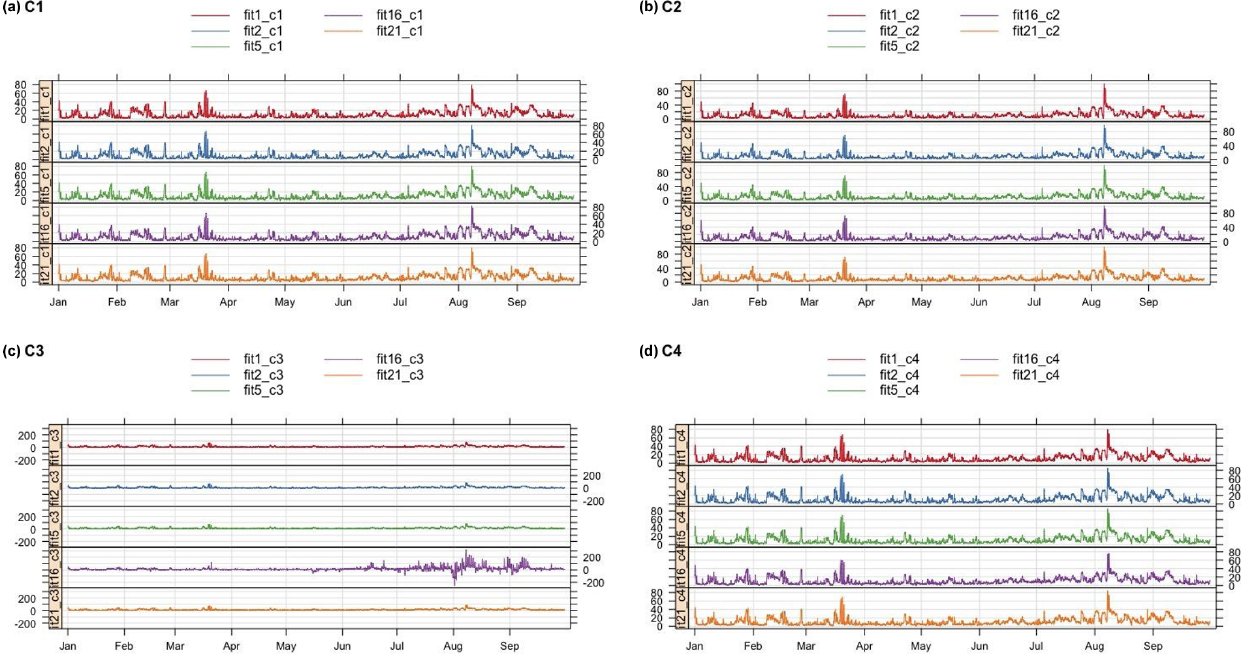
Figure 4. Time series of the different PM 2 . 5 corrected values for Models 1, 2, 5, 16, and 21 across corrections (a) C1, (b) C2, (c) C3, and (d) C4 for the Love My Air monitor CS1. Note that the scales are the same for C1, C2, and C4, but not for C3.